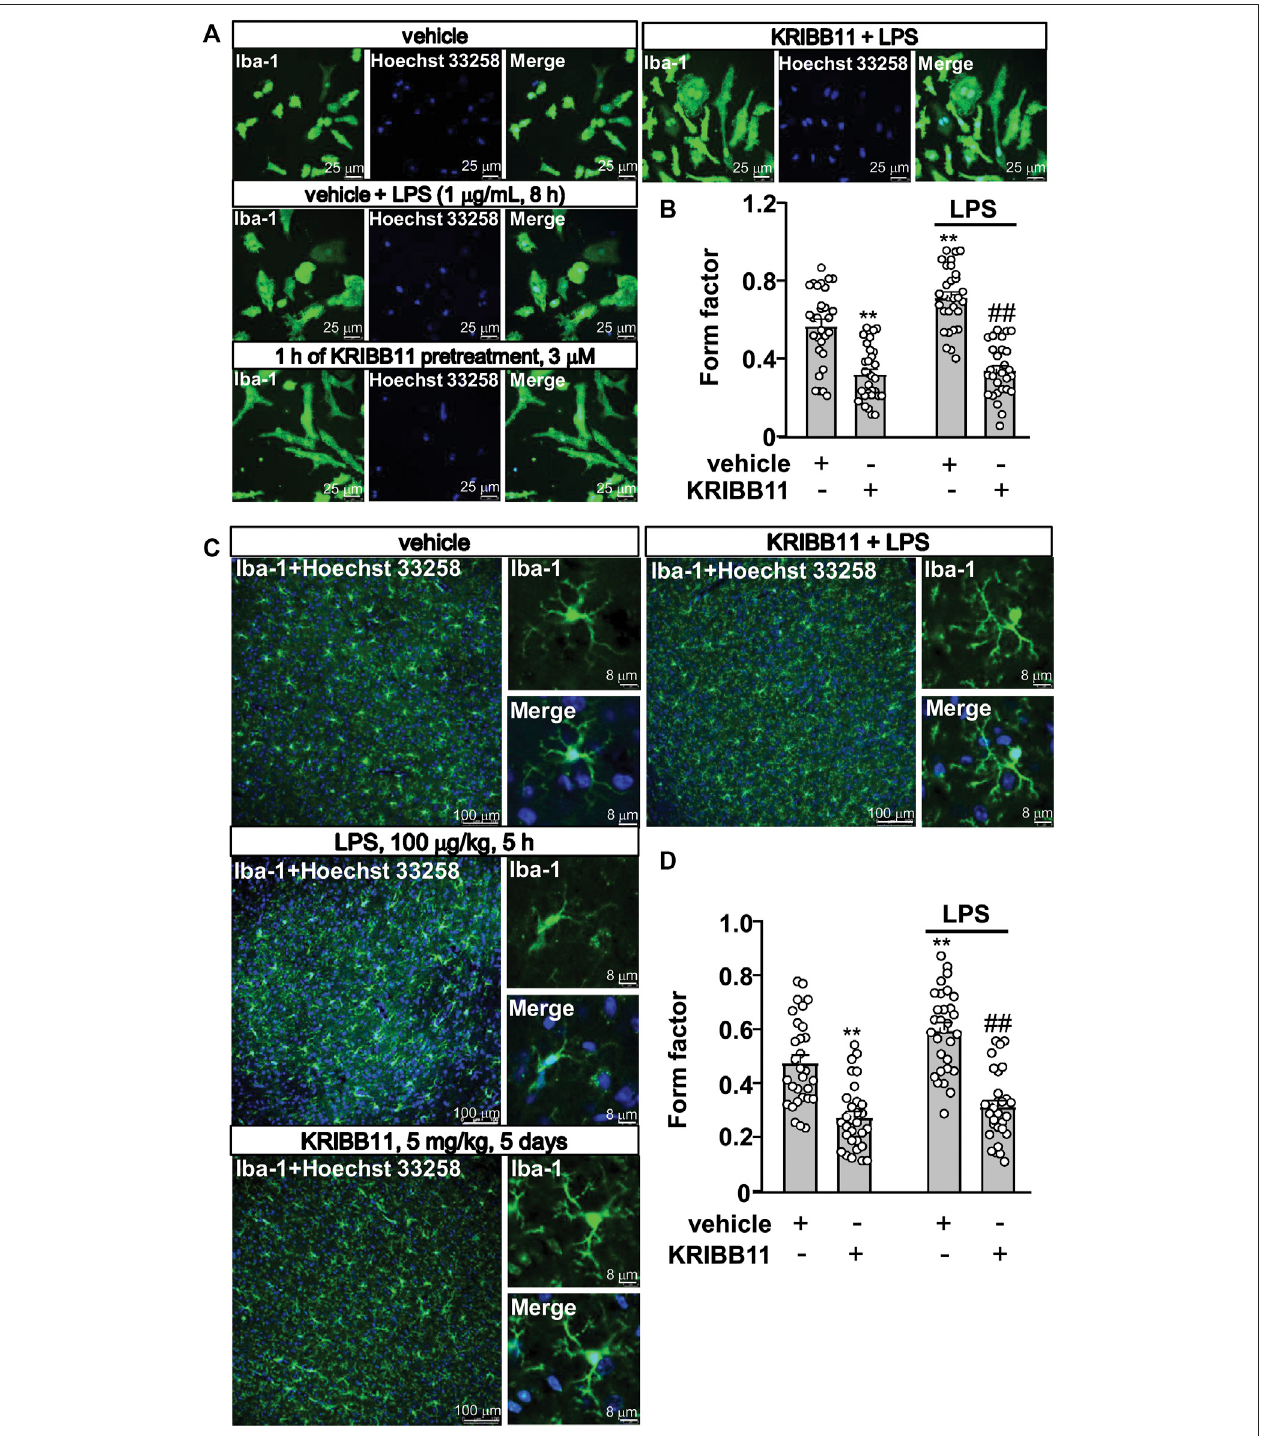
FIGURE 3 | Pro-elongation effects of KRIBB11 on microglial process in in fl ammatory conditions. (A) Representative images showed that KRIBB11 pretreatment (3 μ M, 1 h) prevented LPS (1 μ g/ml, 8 h)-induced retractions of primary cultured microglial process. (B) Quantitative analysis showed the changes in the form factor in primary cultured microglia treated with or without LPS and/or KRIBB11 (** p < 0.01 vs. vehicle, ## p < 0.01 vs. vehicle + LPS). (C) Representative images showed that KRIBB11 pretreatment (5 mg/kg, 5 days) prevented LPS (100 μ g/kg, 5 h)-induced retractions of microglial process in the dorsolateral prefrontal cortex. (D) Quantitative analysis showed the changes in the form factor in microglial processes in the dorsolateral prefrontal cortex in mice treated with or without LPS and/or KRIBB11 (** p < 0.01 vs. vehicle, ## p < 0.01 vs. vehicle+ LPS). For cell shape investigation at conditions in vitro and in vivo , 30cells per condition were analyzedin three independent experiments. Scale bars for in vitro analysis is 25 μ m, and scale bars for in vivo analysis in the low and high magni fi cation images are 100 and 8 μ m, respectively. Data are shown as mean ± SEM.